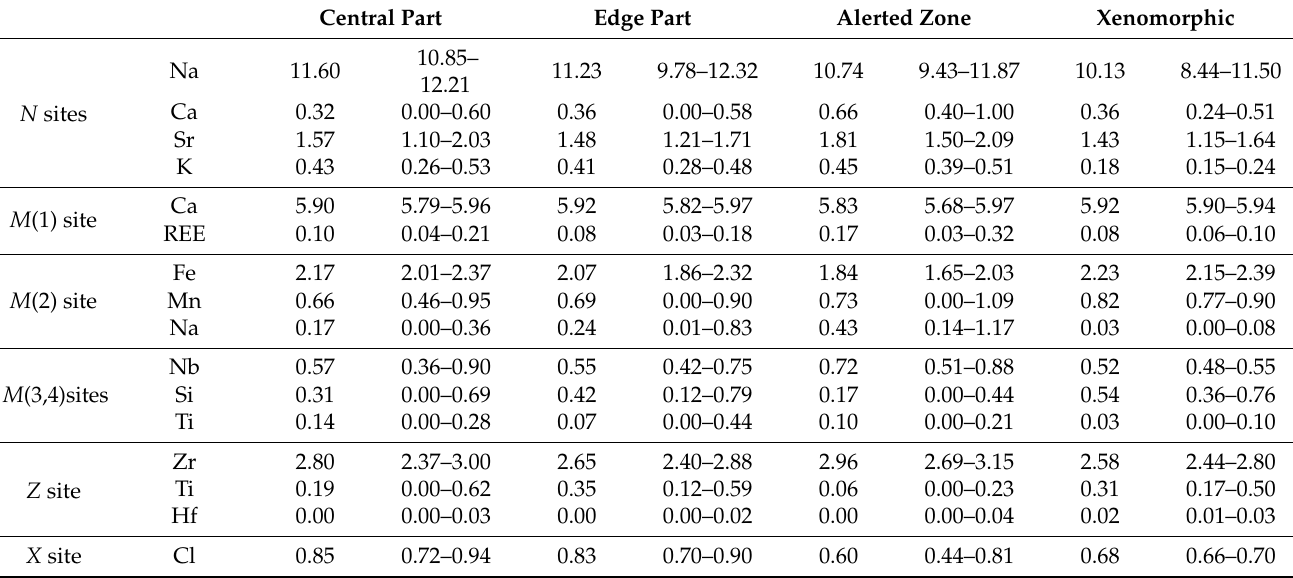
Table 5. Empirical formula coefficients for EGMs from Odikhincha